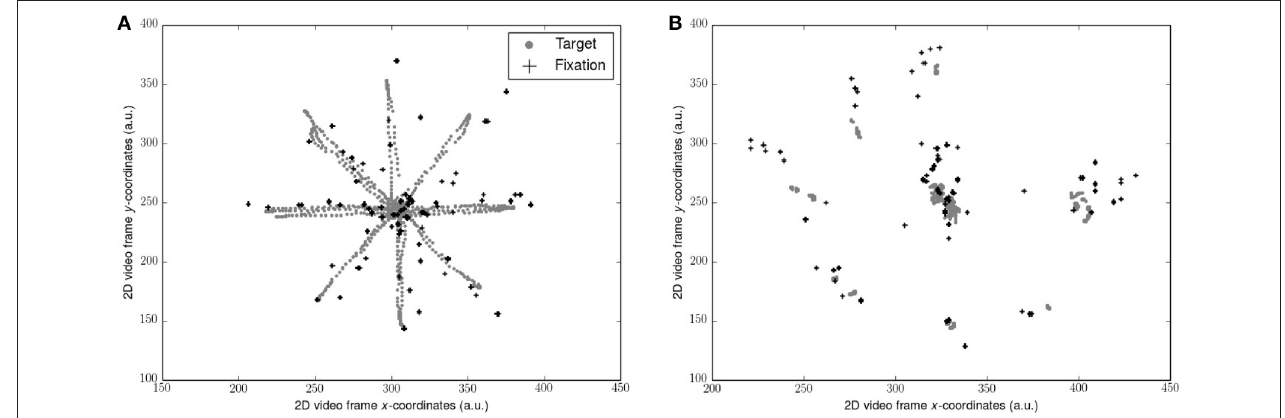
FIGURE 1 | Representation of target trajectory and gaze fixations from 1 participant: (A) during smooth pursuits; (B) during saccades. Coordinates along each axis were taken from the 2D video scene relative to the observer and represent arbitrary units (a.u.). Note that the target position is not stable due to the body sway of the observer. Also note the errors of the fixations compared to the target locations.